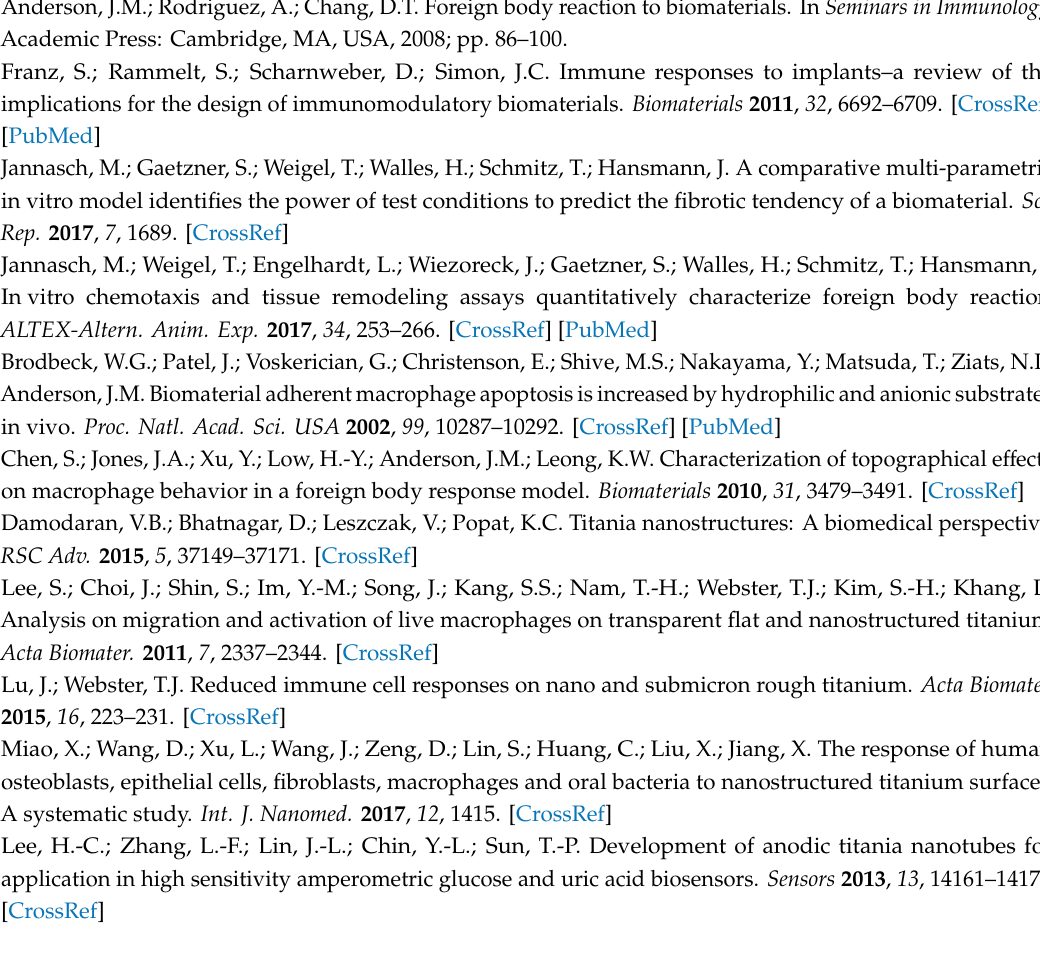
Figure S1: Experimental setup for in vitro biomaterial test; Figure S2: Confirmation of macrophage phenotype prior to material testing; Figure S3: Morphological analysis of biomaterial-resident